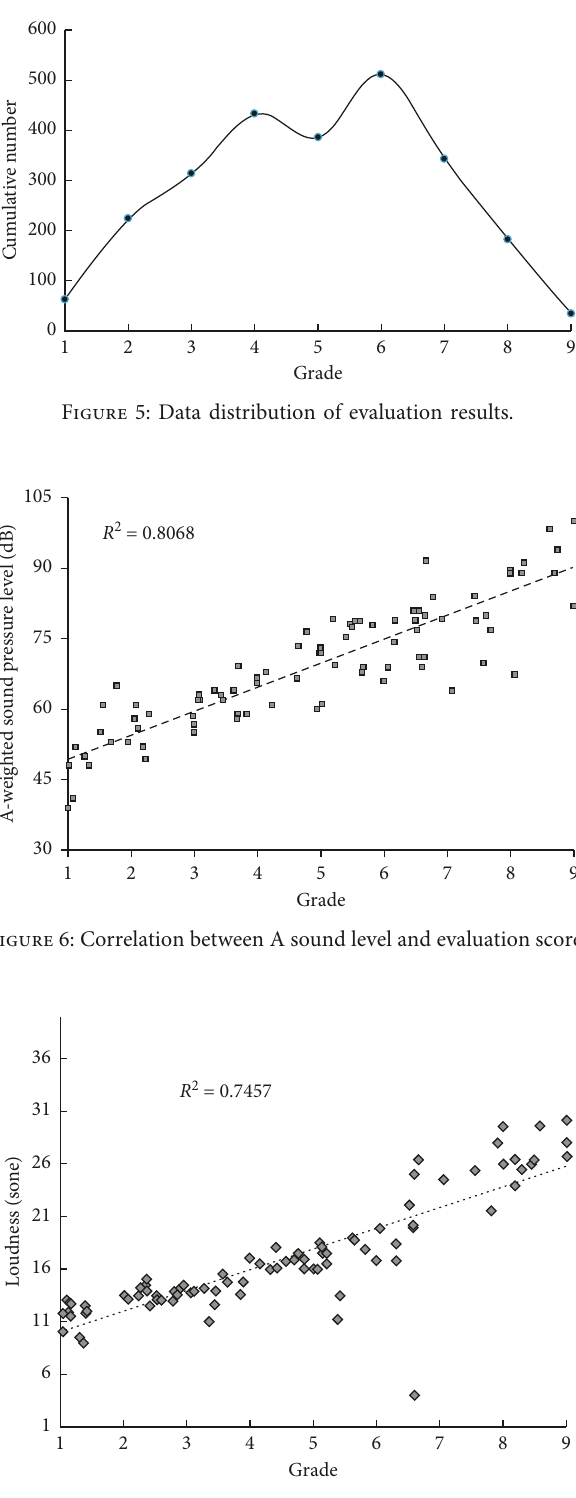
Figure 7: Correlation between loudness and evaluation score.